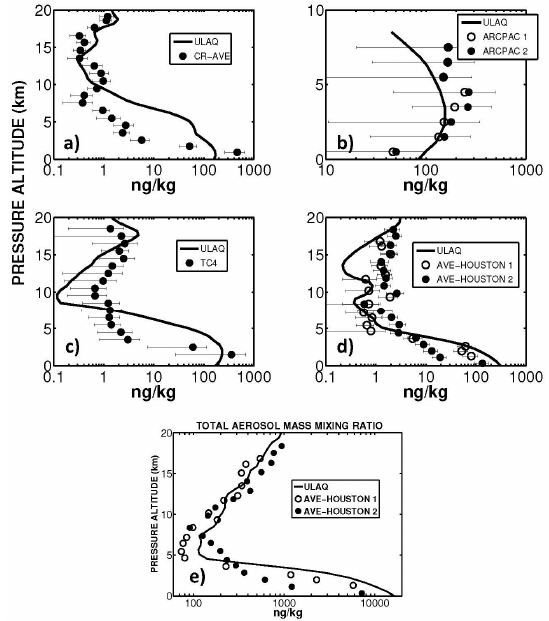
Figure 2. Panels ( a – d ): black carbon aerosol vertical profiles calculated in the ULAQ model and compared to measurements from aircraft campaigns [60] (see Table 2). Measurements were made onboard of NOAA research aircrafts at tropical latitudes (left panels (a) and (c)), high latitudes (upper right panel (b)) and mid latitudes (bottom right panel (b)), over Central and North America. Panel ( e ): comparison of calculated and observed total aerosol mass mixing ratio (Houston